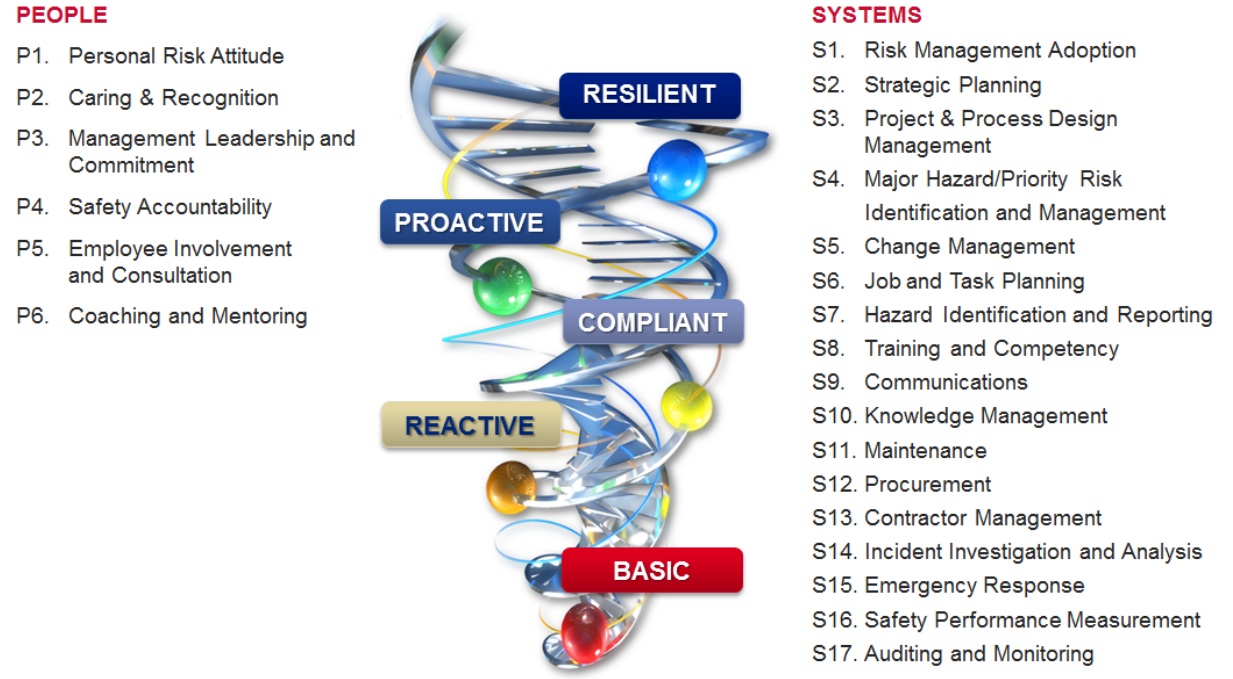
Figure 2. Anglo American Plc maturity model